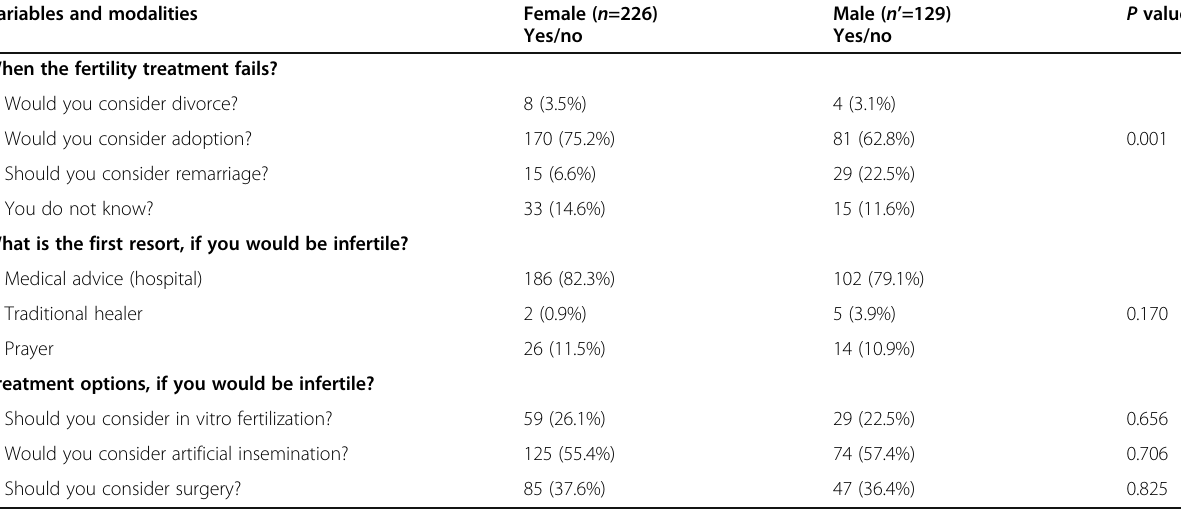
Table 3 The hypothetical answers regarding possible future infertility, distributed by gender Variables and